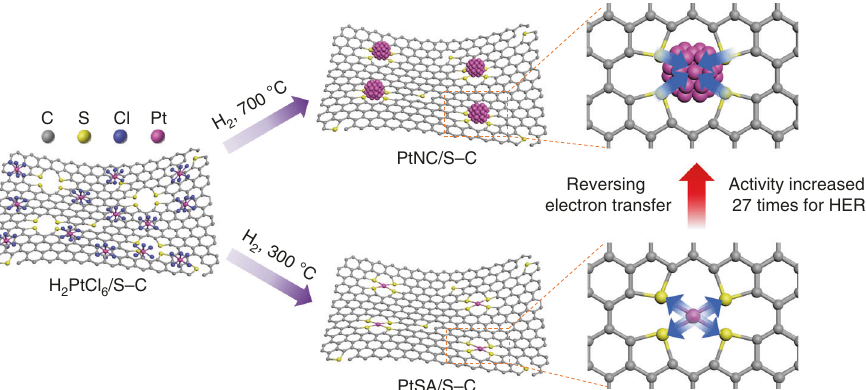
Fig. 1 Schematic model of the catalyst preparation process and metal size-dependent charge transfer. PtSA/S – C and PtNC/S-C were prepared by wet- impregnation of chloroplatinic acid on the S – C supports followed by H 2 -reduction at 300 and 700 °C, respectively. When Pt size increases from single- atom to nanocluster, the electron transfer direction is reversed, resulting in greatly enhanced activity for catalyzing HER